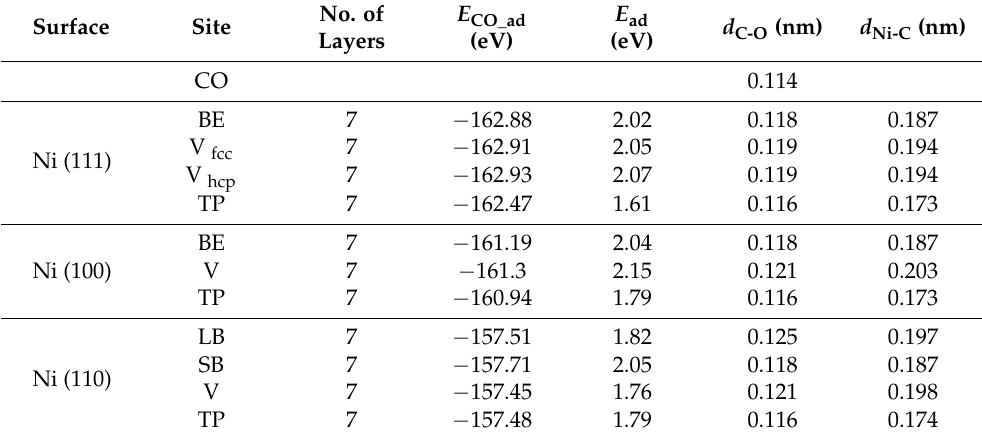
Table 1. Adsorption parameters of CO adsorption on (111), (100) and (110) surfaces at a 0.25 mL.